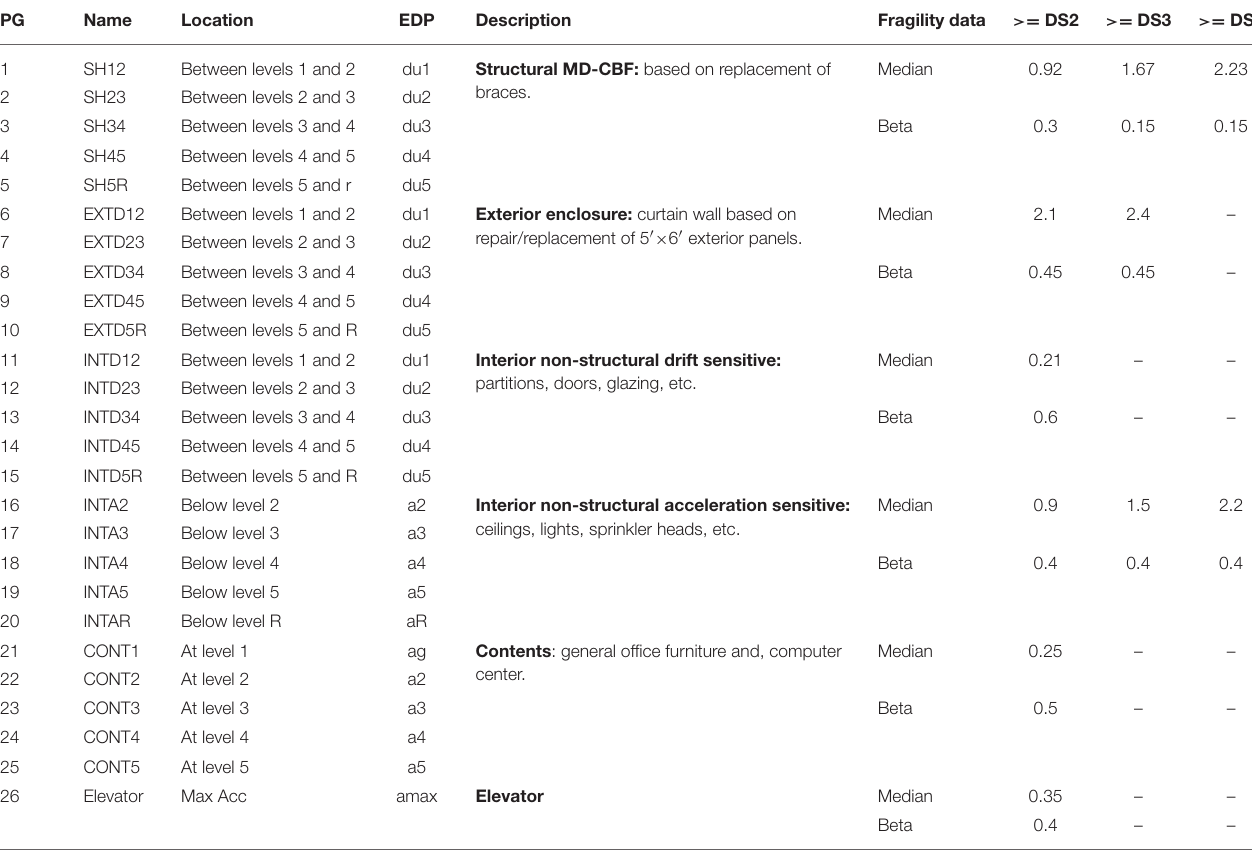
TABLE 5 | Summary of performance groups and their corresponding fragility curve